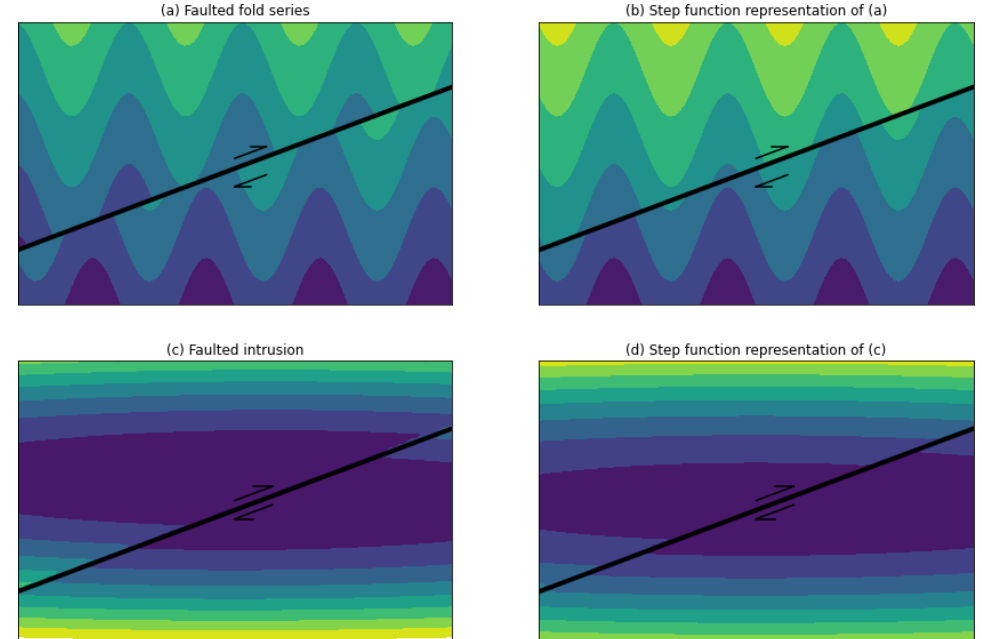
Figure 2. Comparison of true fault kinematics and step function results. (a) A fold series that has been faulted by a reverse fault, where the fold hinges are offset. Panel (b) shows the same fold series as (a) when modelled using a step function where the scalar field on the hanging wall is increased resulting in no displacement of the fold hinges. Panel (c) is a faulted intrusion where the volume is not affected by the fault. Panel (d) shows the same intrusion modelled with a step function where the intrusion shrinks on the hanging wall, resulting in a lower volume intrusion.